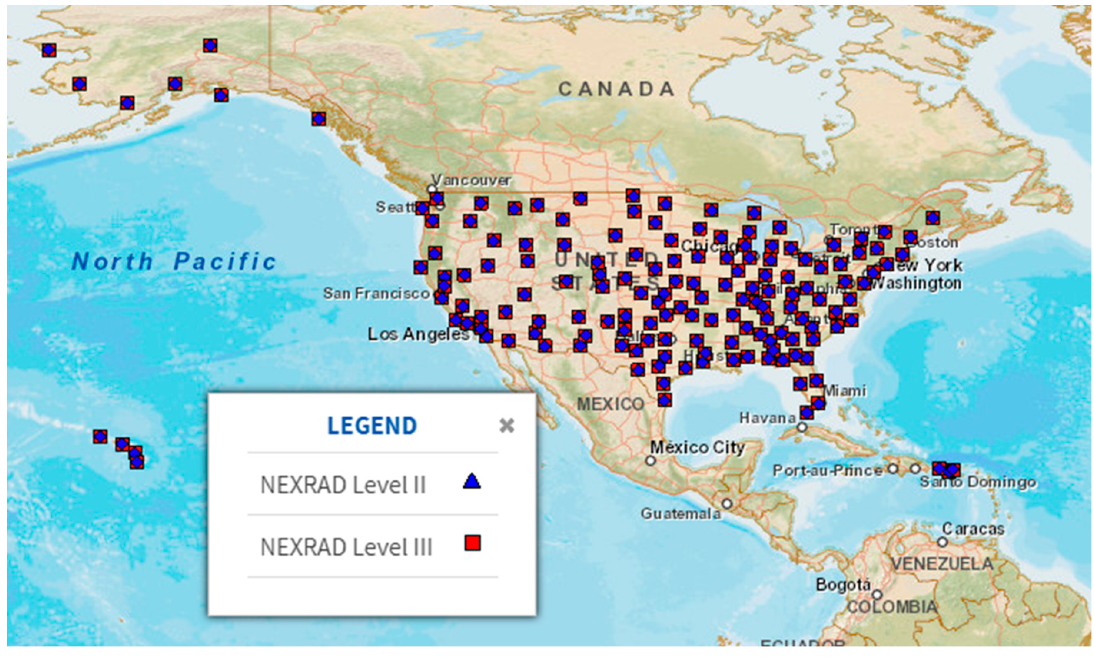
Figure 14. NOAA NCDC Radar Data Map (NEXRAD Level II and III).